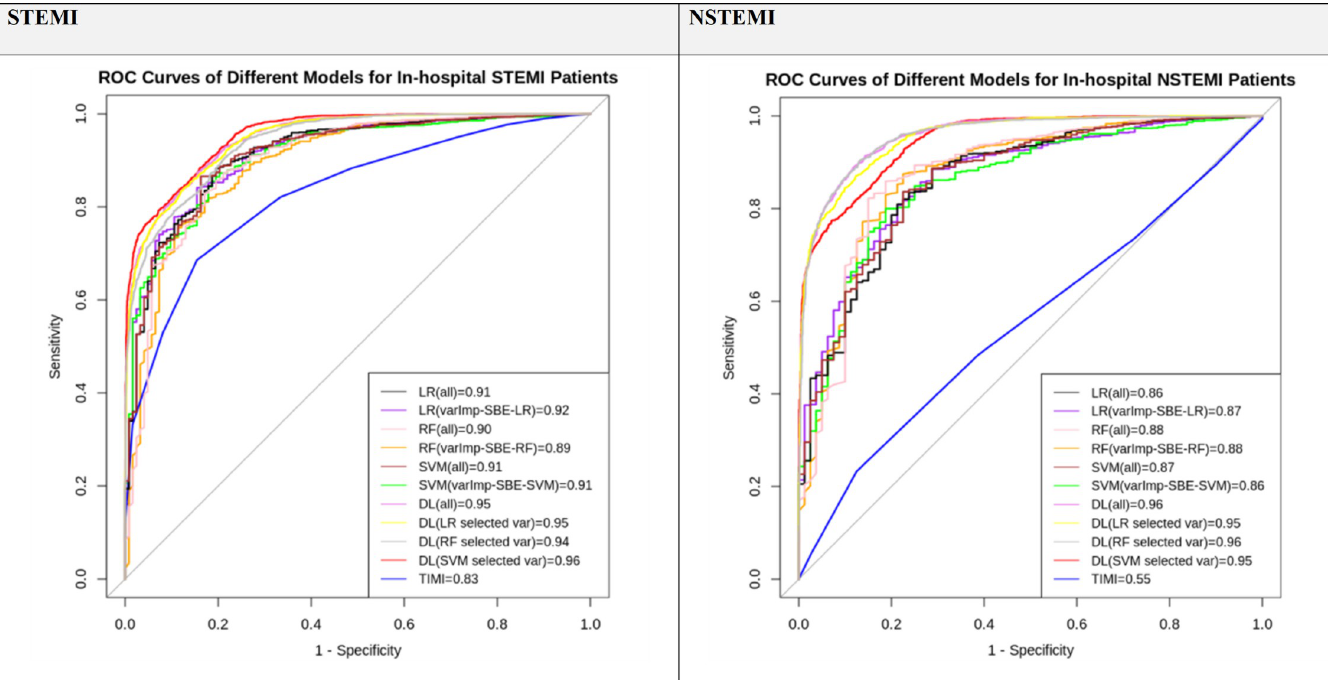
Fig 3. ROC curves for in-hospital mortality prediction for STEMI and NSTEMI